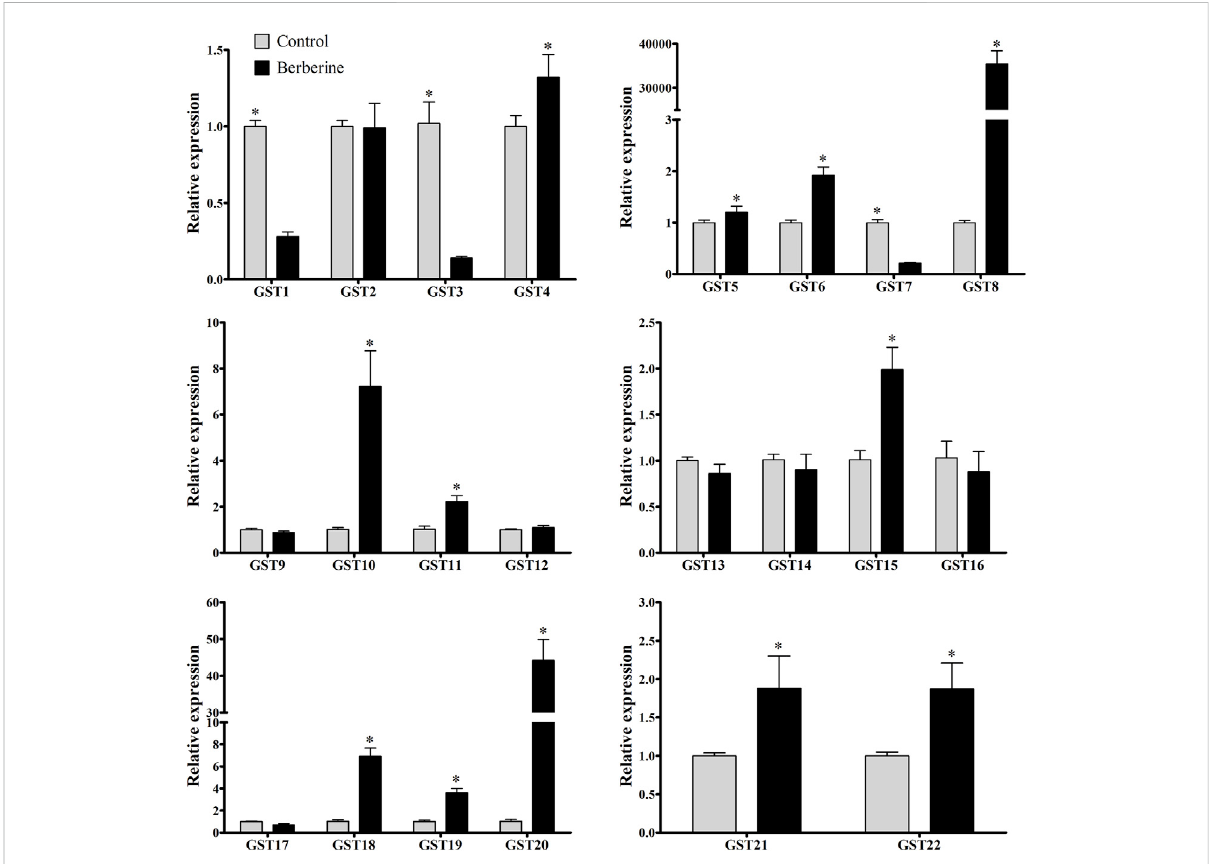
FIGURE 3 Relative expression of GSTs by qRT-PCR. Black and grey bars indicate larvae under berberine treatment and larvae under control treatment (water),respectively,basedontheratiooftreatmenttocontrol.Statisticallysigni fi cantdifferences( p < 0.05)wereevaluatedby t -testandshownwith asterisk (*) based on three biological replicates and three technical replicates.